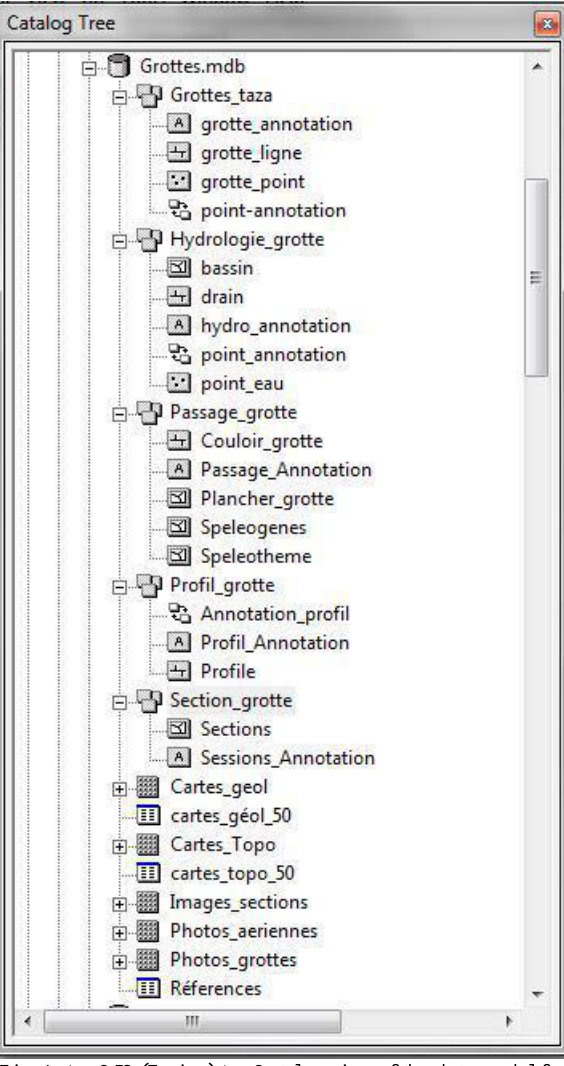
Fig. 4- ArcGIS (Esri ©) ArcCatalog view of the data model for the Moroccan Atlas